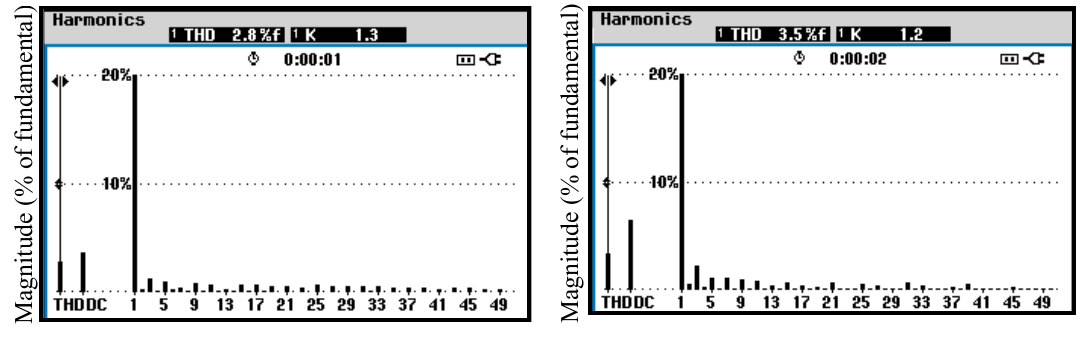
Figure 27. Grid current spectrum analysis of BSS-FBC and typical two-stage topology: ( a ) 100% rated power of BSS-FBC; ( b ) 50% rated power of BSS-FBC; ( c ) 100% rated power of typical two-stage